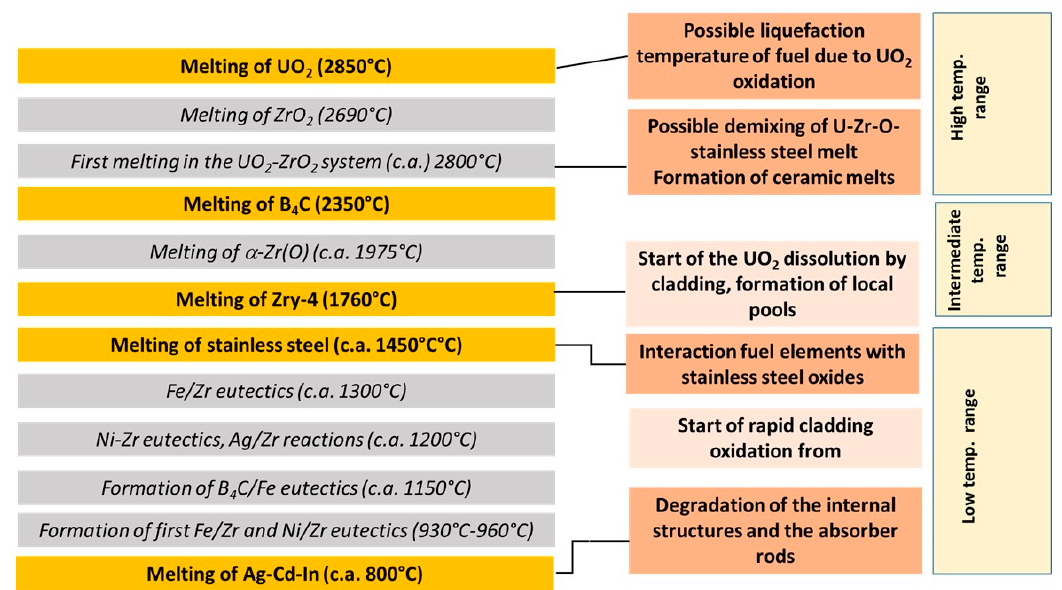
Figure 1. LWR severe accident-relevant melting and chemical interaction temperatures which result in the formation of liquid phases (figure inspired from [18]).